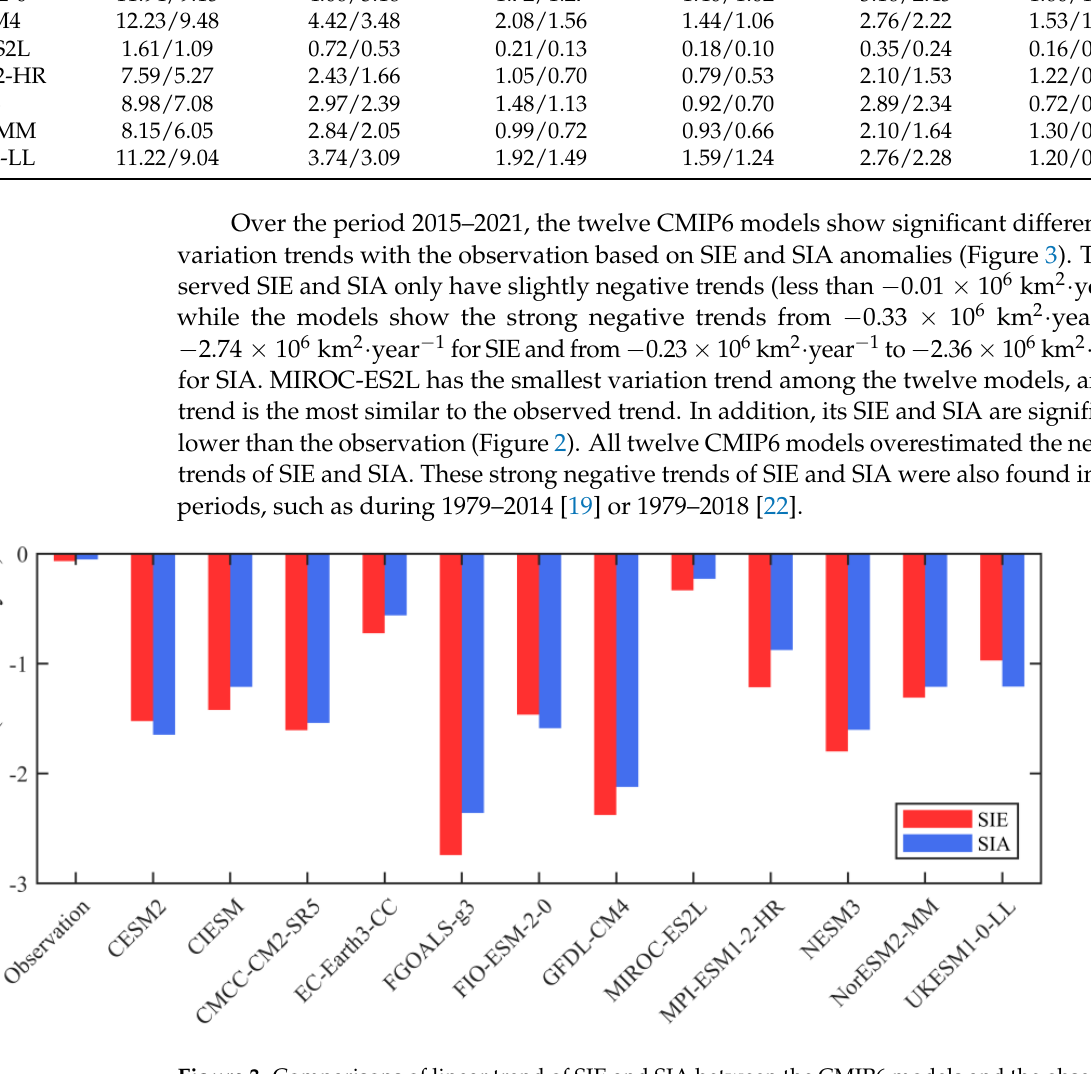
Figure 3. Comparisons of linear trend of SIE and SIA between the CMIP6 models and the observation in the whole Antarctic over the period 2015–2021.